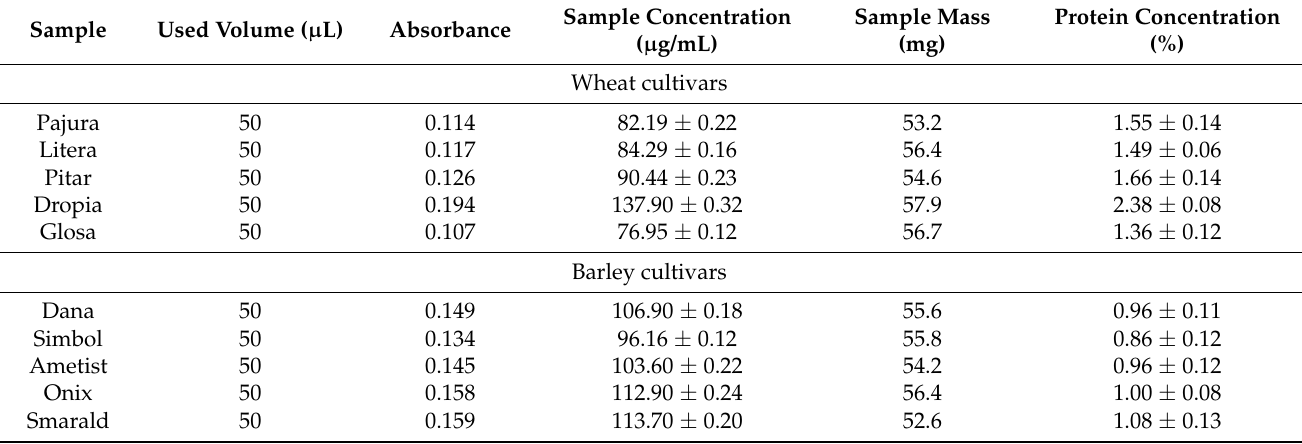
Table 5. Measured contents of the extracted proteins concentration in distilled water (means values ± standard